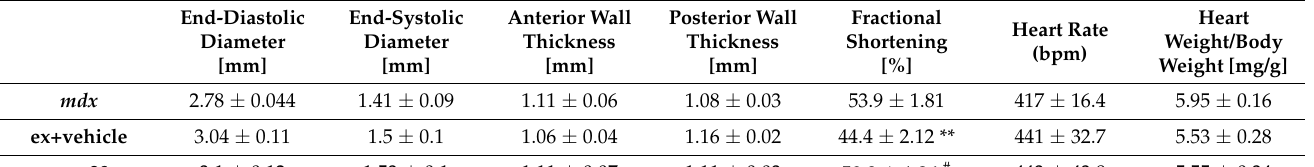
Table 1. Summary of the main echocardiographic parameters examined in exercised and control mdx . Data are expressed as mean +/ − S.E.M., n = 8–10/condition # p < 0.05 ( ex mdx vs. ex + c20), ** p < 0.01 ( mdx vs. ex mdx ), one-way ordinary ANOVA with Bonferroni correction for multiple comparisons.